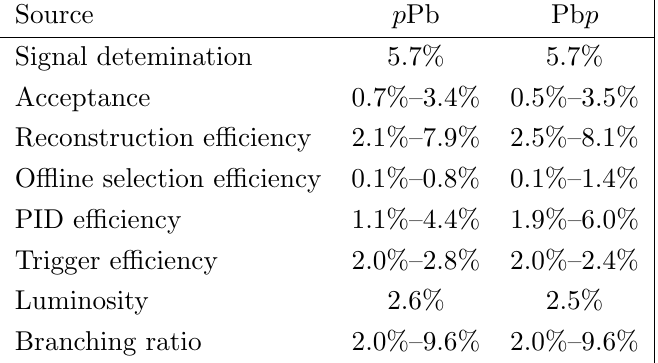
Table 2 . Systematic uncertainties (in percent) on the cross-section measurements. The ranges indicate the minimum and maximum values in di(cid:11)erent bins, among all (cid:7) ( nS )